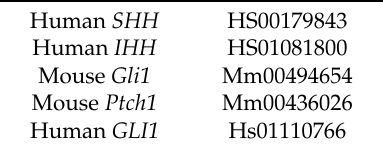
Table 1. Real-time PCR probe